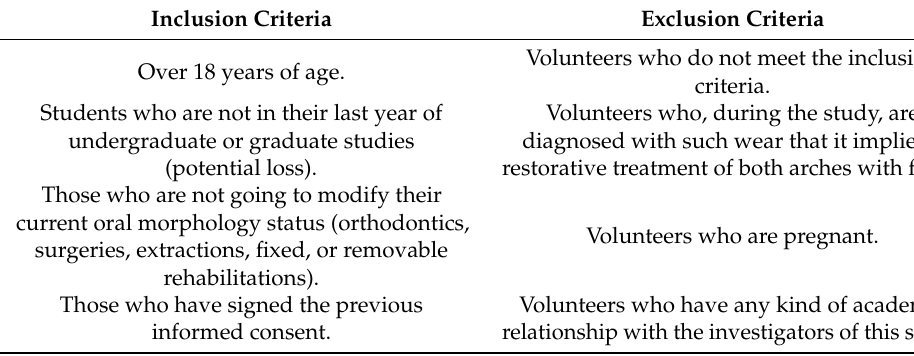
Table 1. Inclusion/exclusion